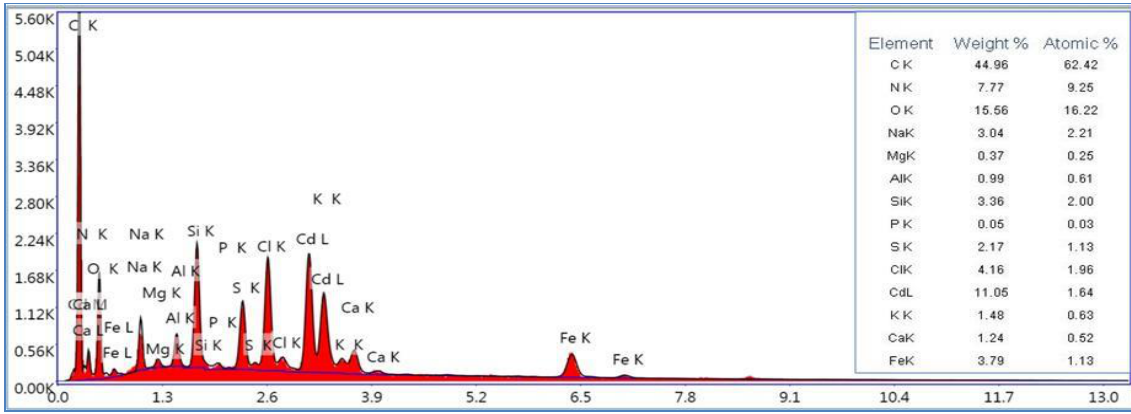
Fig. 4: EDS pattern taken from the point 1 in Fig.